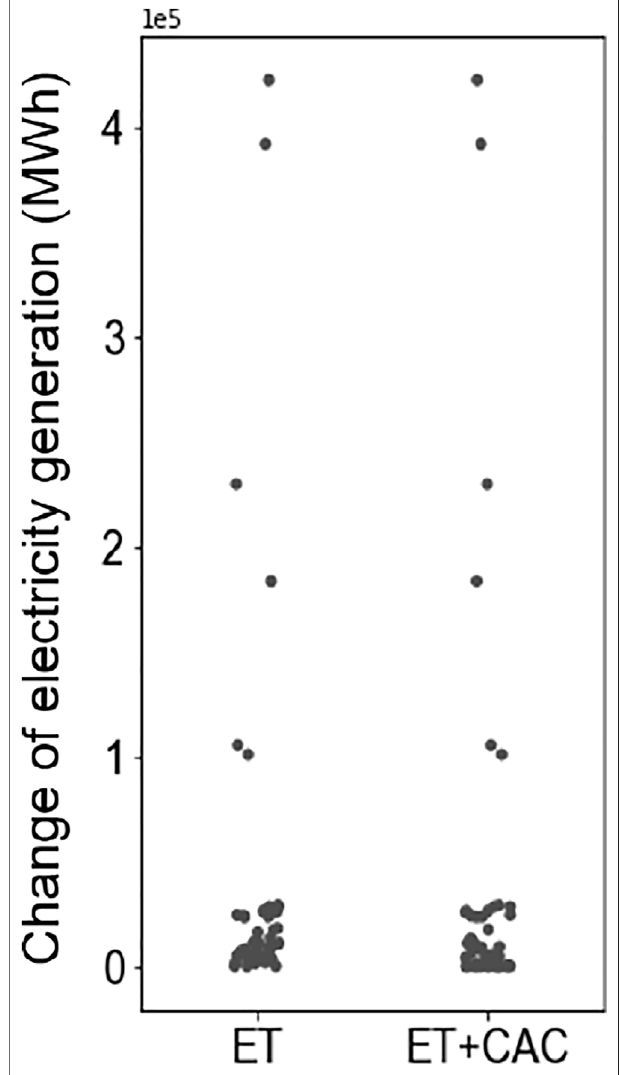
FIGURE 3 | Changes of each power plant in electricity generation under the emission trading scenario and the mixed emission trading and command- and-control ( ET + CAC )